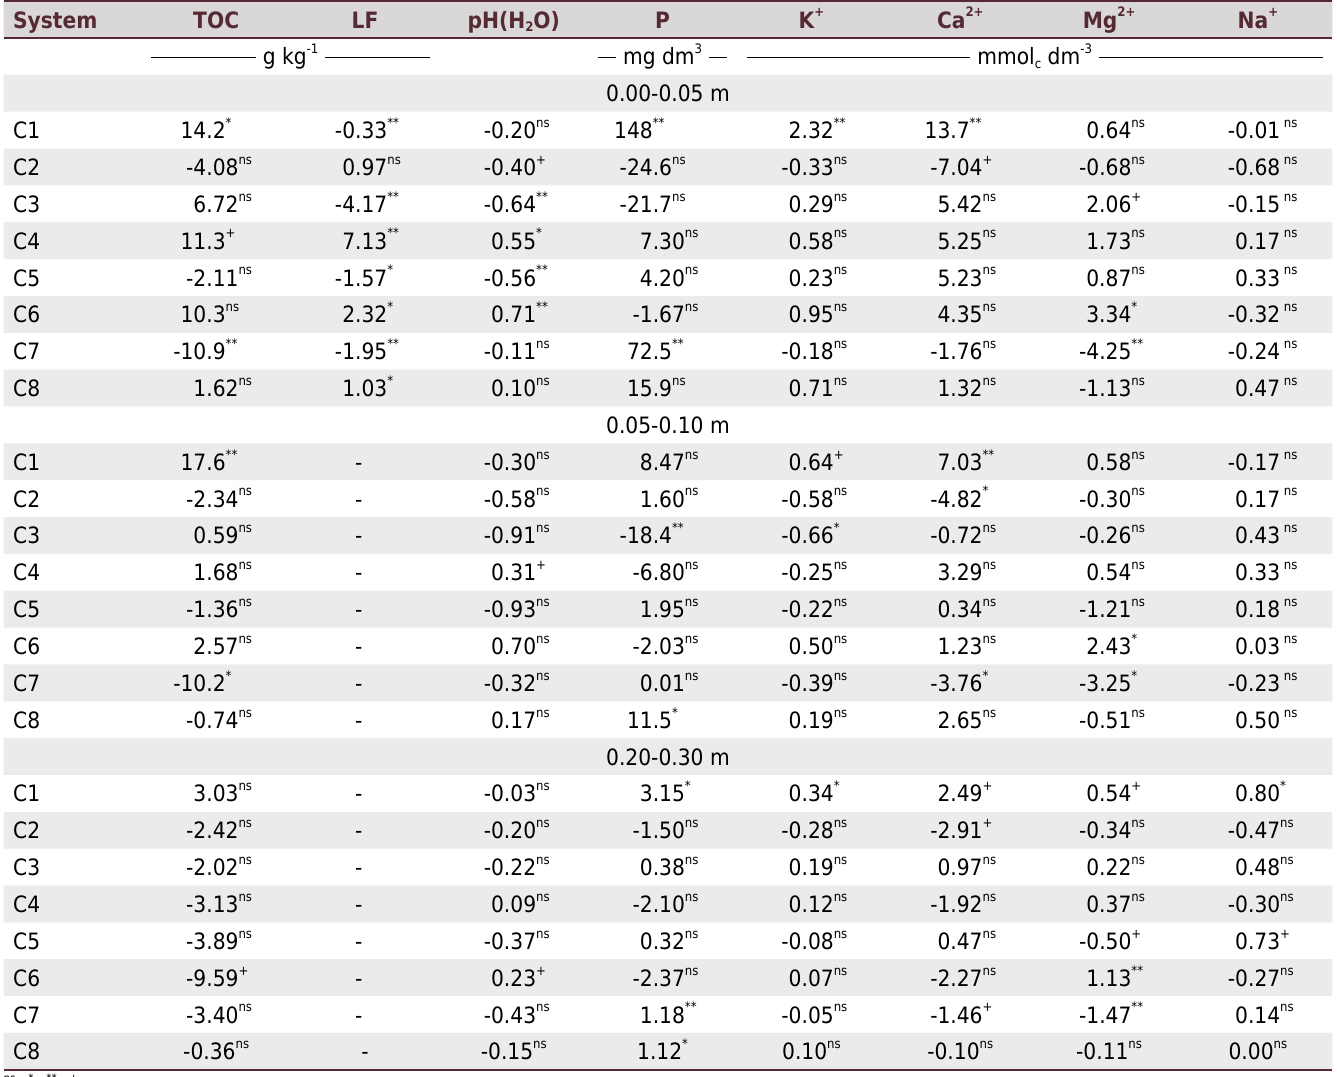
Table 2. Mean squares and significance by F-test of the orthogonal contrasts tested for the chemical properties, total organic carbon (TOC), and light-fraction organic matter (LF) of an Arenic Kandiustults cultivated with early dwarf cashew under different management systems in the municipality of Pacajus, Ceará, Brazil